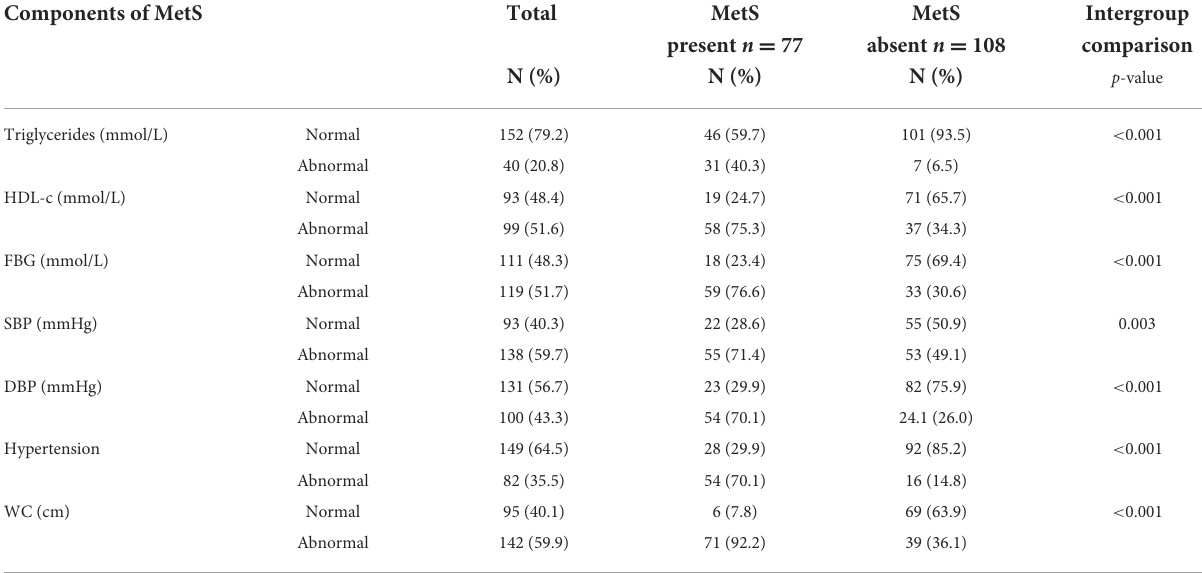
TABLE 3 Risk factors of MetS grouped by the presence and absence of MetS. Components of